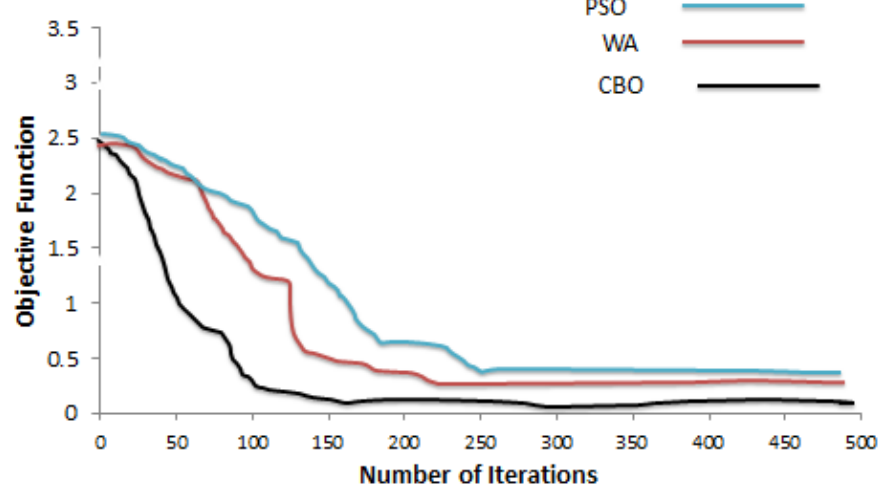
Figure 9. Convergence curve for algorithms using the number of iterations and objective function value.